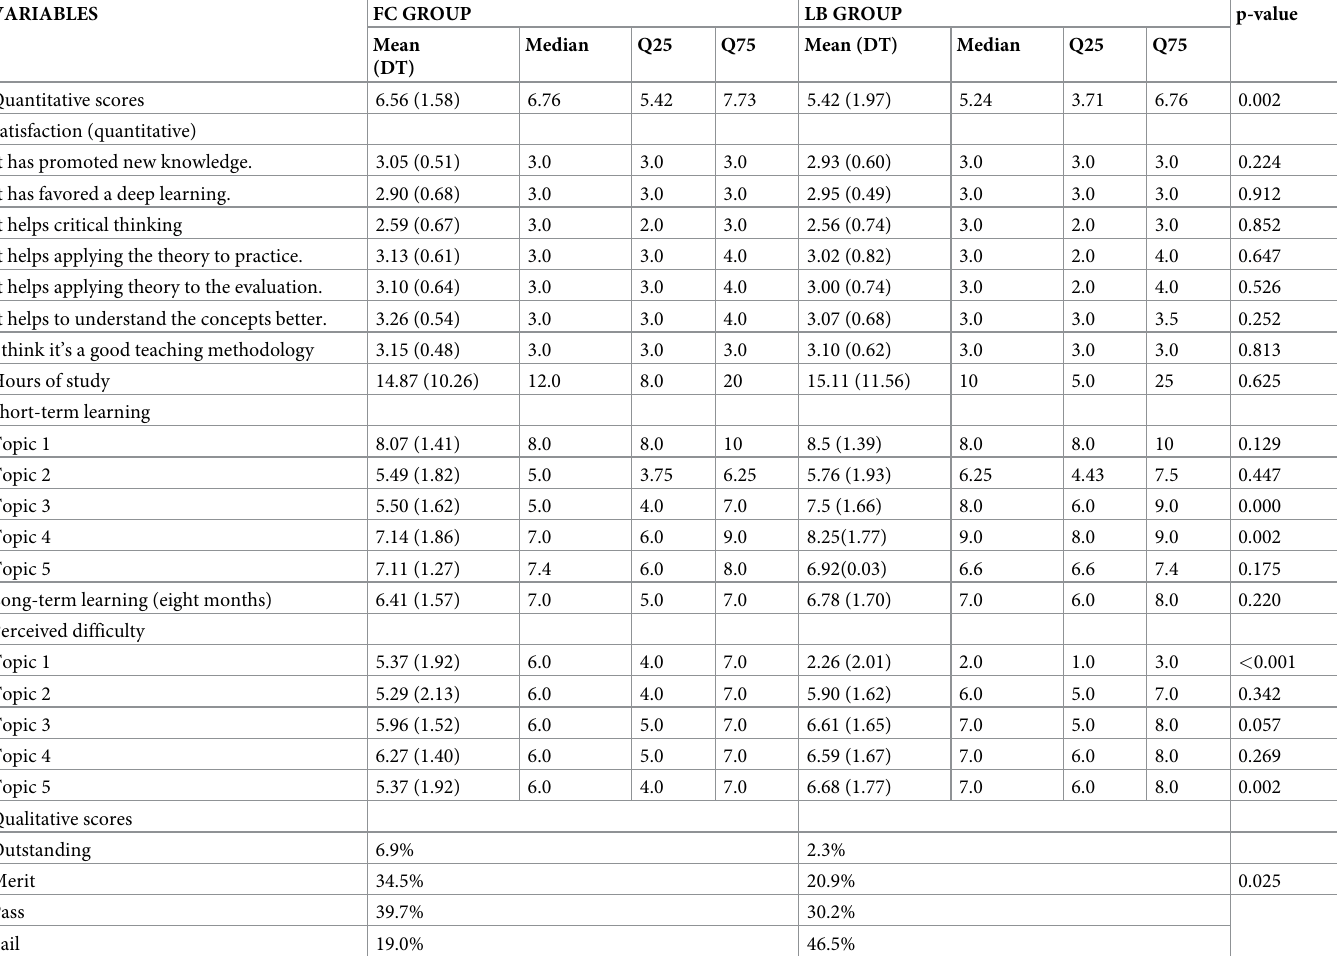
Table 3. Comparison between the FC group and the control group for the outcomes of academic performance (quantitative and qualitative), satisfaction with teach- ing, study hours for the exam, short-term learning and perceived difficulty